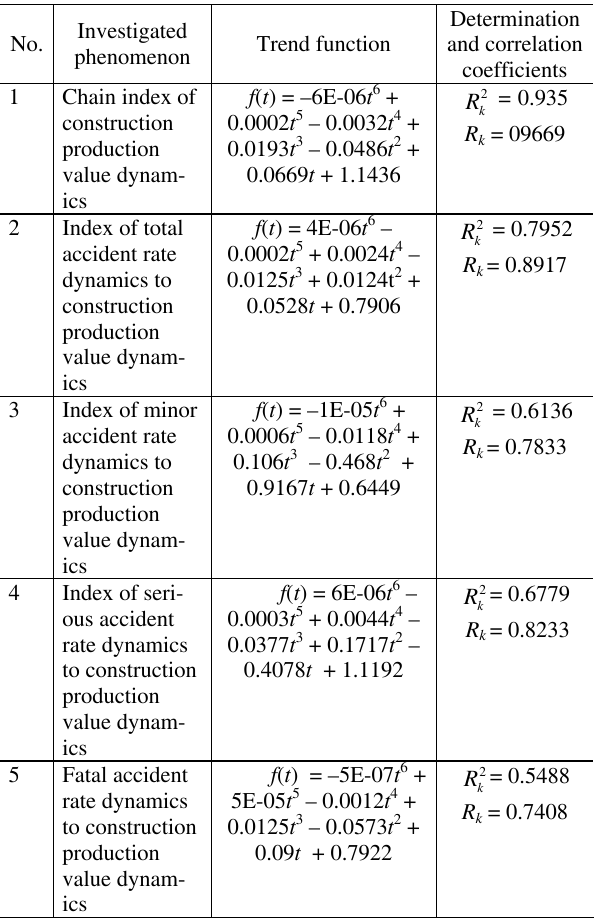
Fig 11 . Index of fatal accident rate dynamics relative to construction production value dynamics in